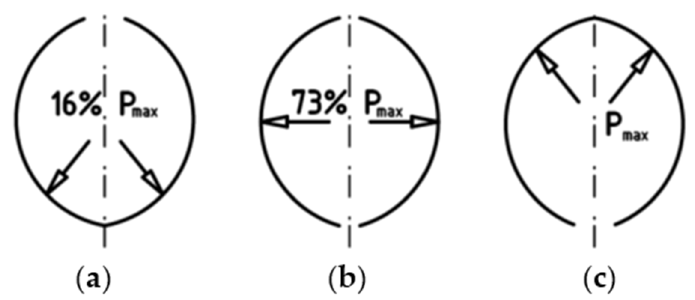
Figure 1. Unit pressure value distribution during the briquetting process in a roller press. P max , maximum unit pressure [64]: ( a – c ) the successive compaction phases during the rotation of the rollers.